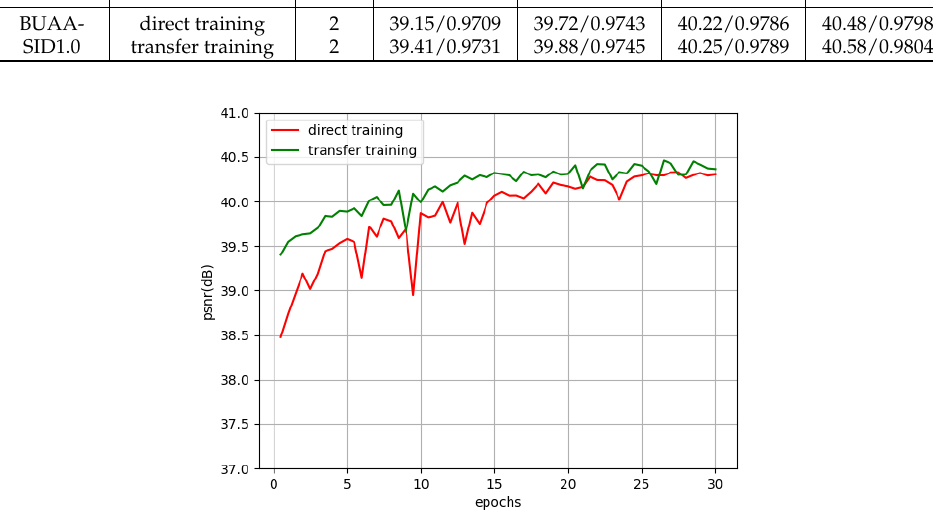
Figure 7. Performance of DRCN training by different